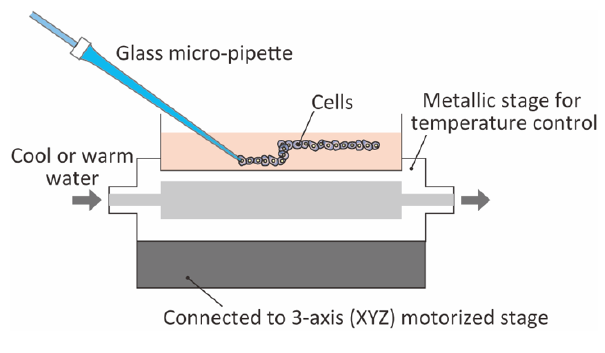
Figure 1. Micro-injection and three-dimensional position control system for three-dimensional cell drawing. ( a ) Experimental setup consisting of micro-injector and 3-axis motorized stages, ( b ) temperature control of system for collagen sol/gel.